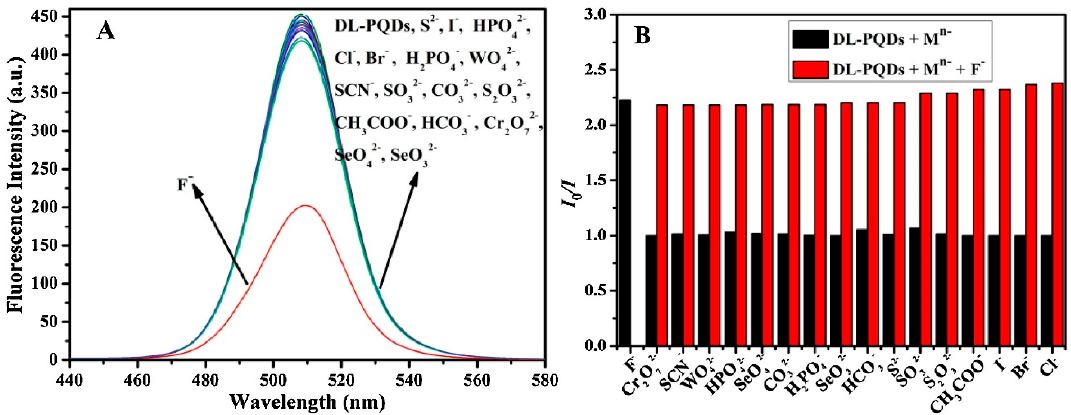
Figure 15. ( A ) Fluorescence response of dual ligand capped perovskite quantum dots (DL-PQDs) to different anions and F − (90 µM for F − and 450 µM for other anions). ( B ) Interference studies of the novel nanosensor toward F − . The black bars represent the fluorescence response of DL-PQDs to F − and other anions (90 µM for F − , 450 µM for other anions). The red bars represent the change of emission occurred after the subsequent addition of 90 µM of F − to the above solutions (reproduced with the permission from reference [151]).